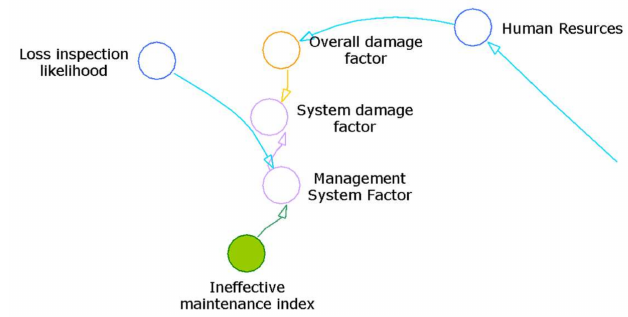
Figure 8. System dynamics elements.